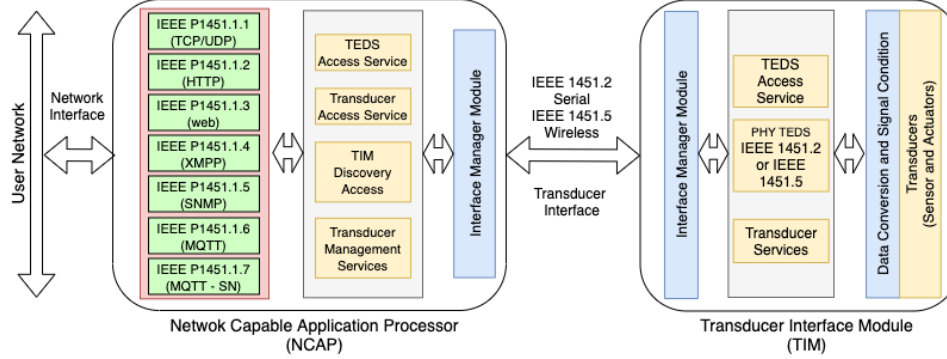
Figure 1. Network topology